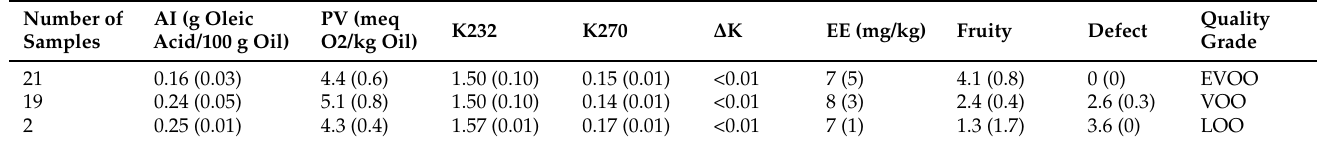
Table 1. Chemical and sensory characterization of the samples (overall mean and standard deviation), and relevant quality degree, in accordance with current legislation. Number of AI (g Oleic Samples Acid/100 g